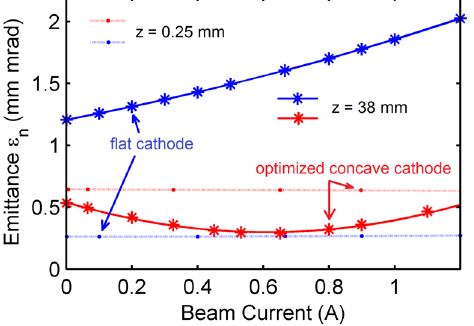
FIG. 24. Emittance vs. current for a flat and concave cathode.